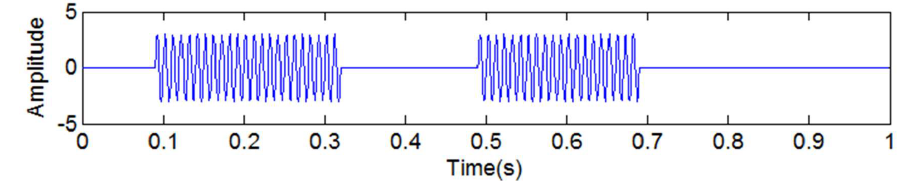
Figure 18. The simulated discontinuous signal y 15 ( t ).